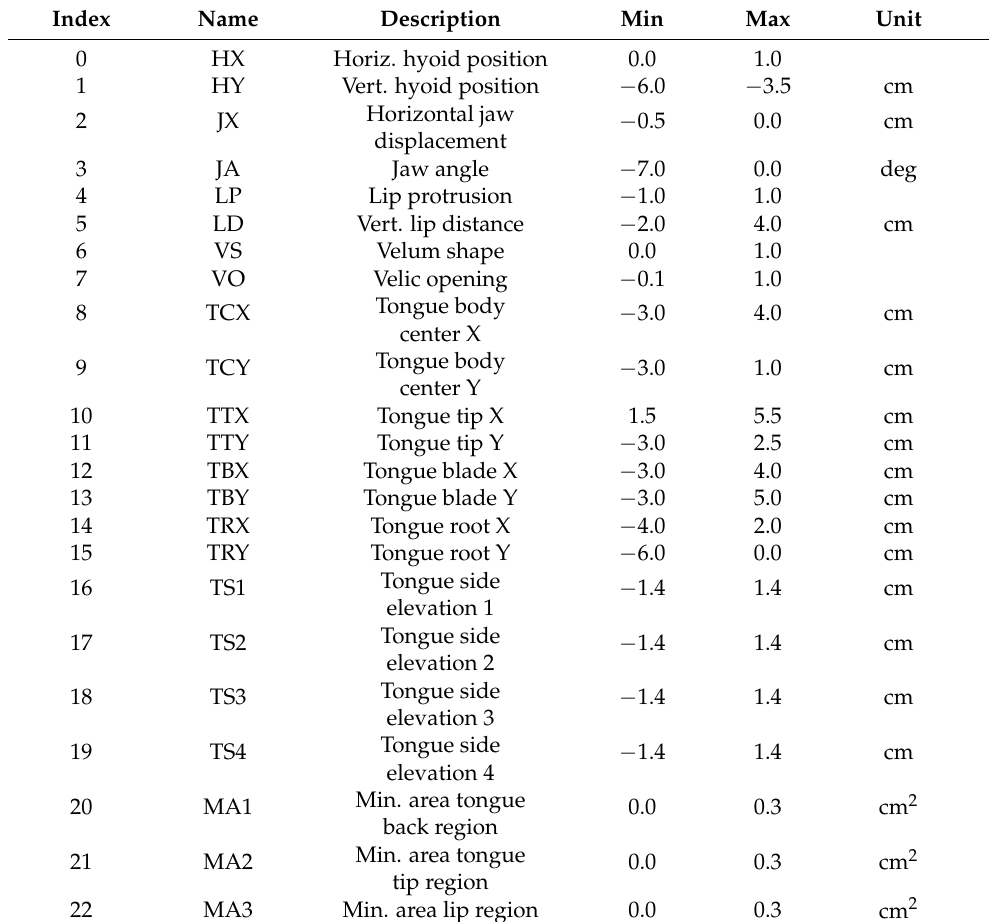
Table 1. Control parameters of the vocal tract model (adapted from [7]). For each parameter, the value range and the unit is given. Parameters without a unit specify relative